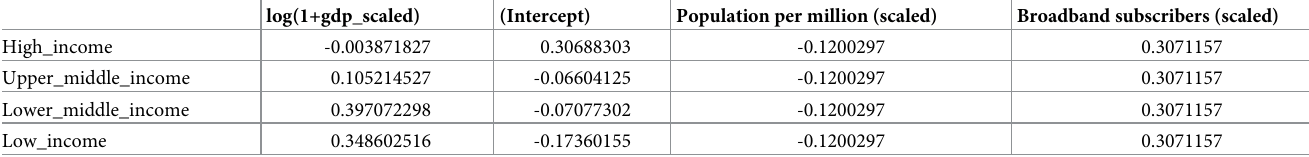
Table 5. Global models IV. GDP random effects model by income category (DV: download per capita rounded, quasipoission).